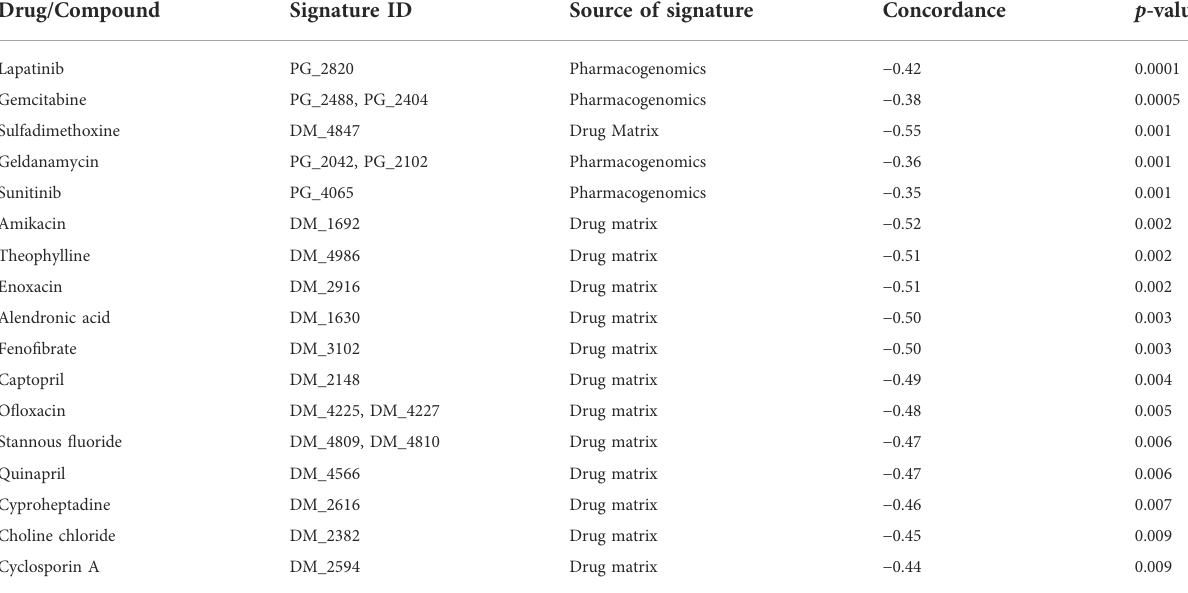
TABLE 3 Top drug and chemical compound signatures negatively associated with the COVID-19 speci fi c signature. Signatures with p < 0.01 and negative concordance value below − 0.35 are listed.